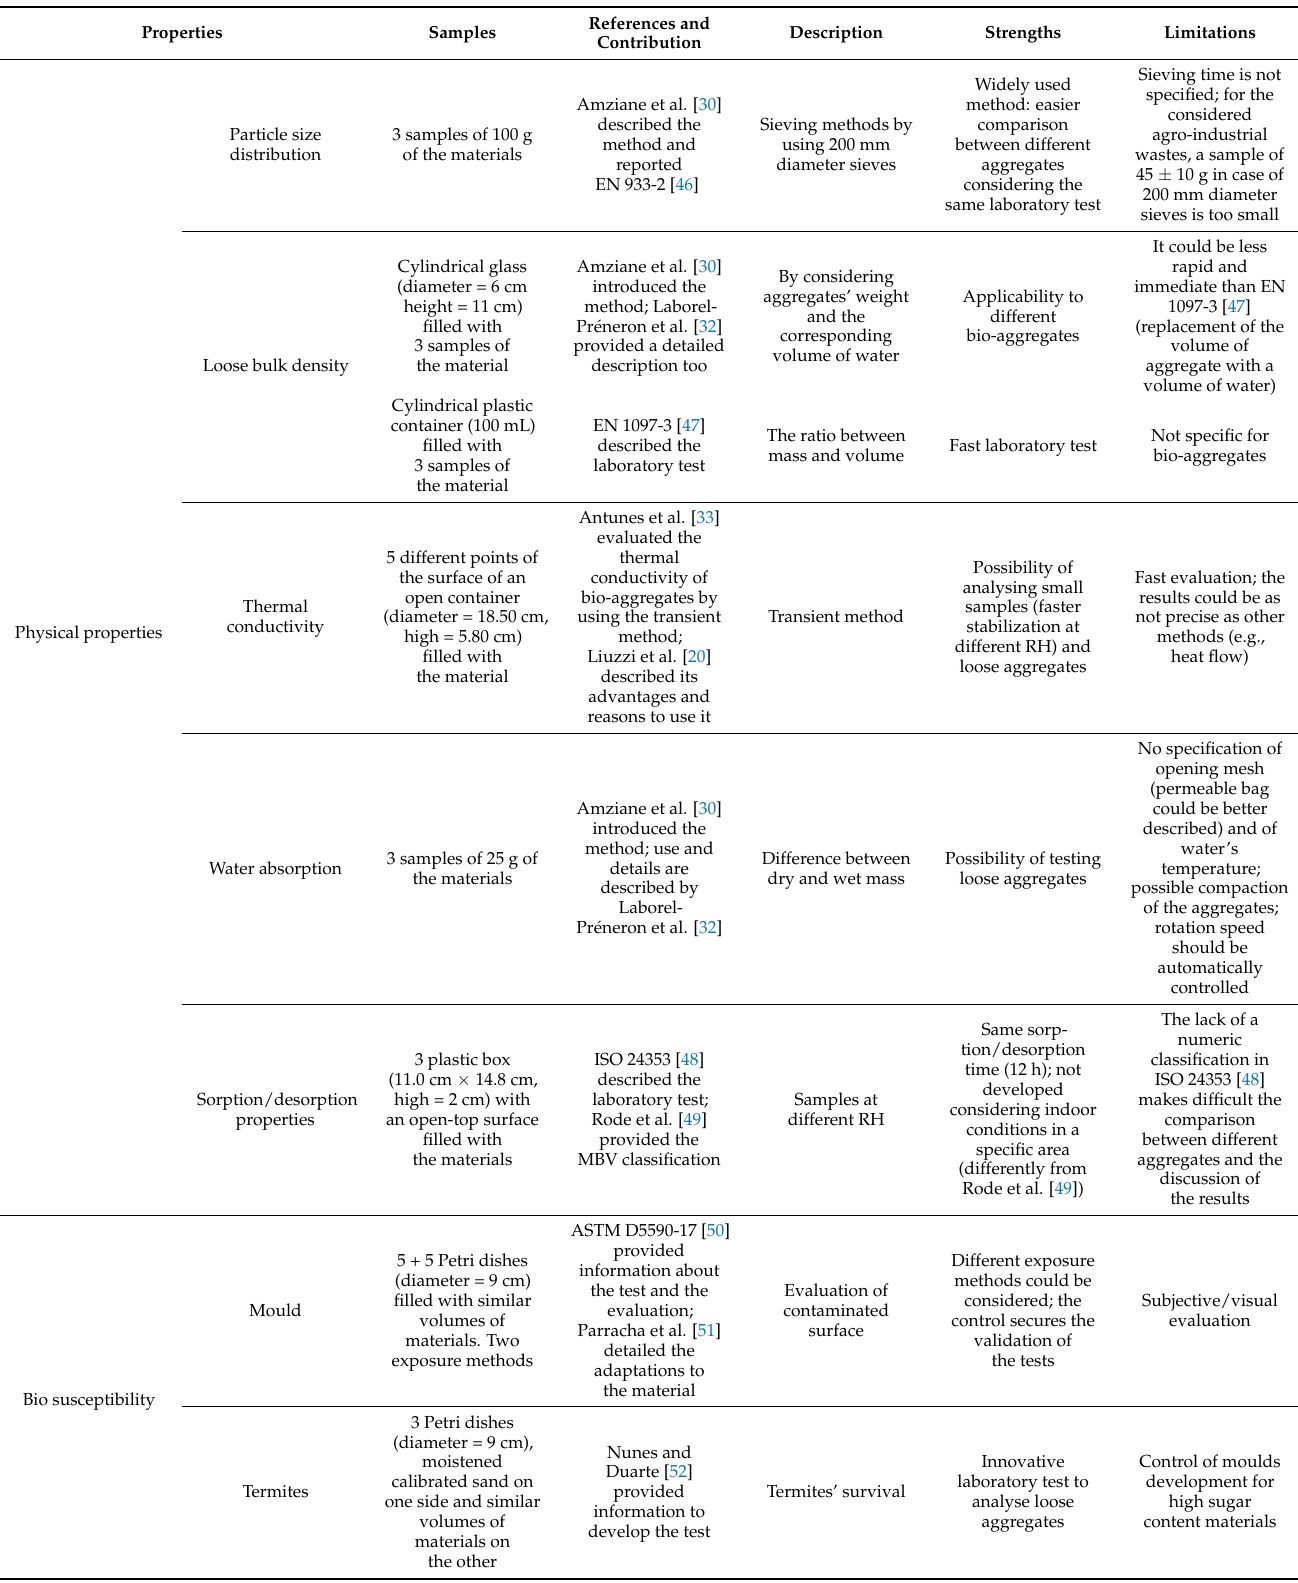
Table 2. Summary of laboratory tested properties, samples, considered/adapted references and